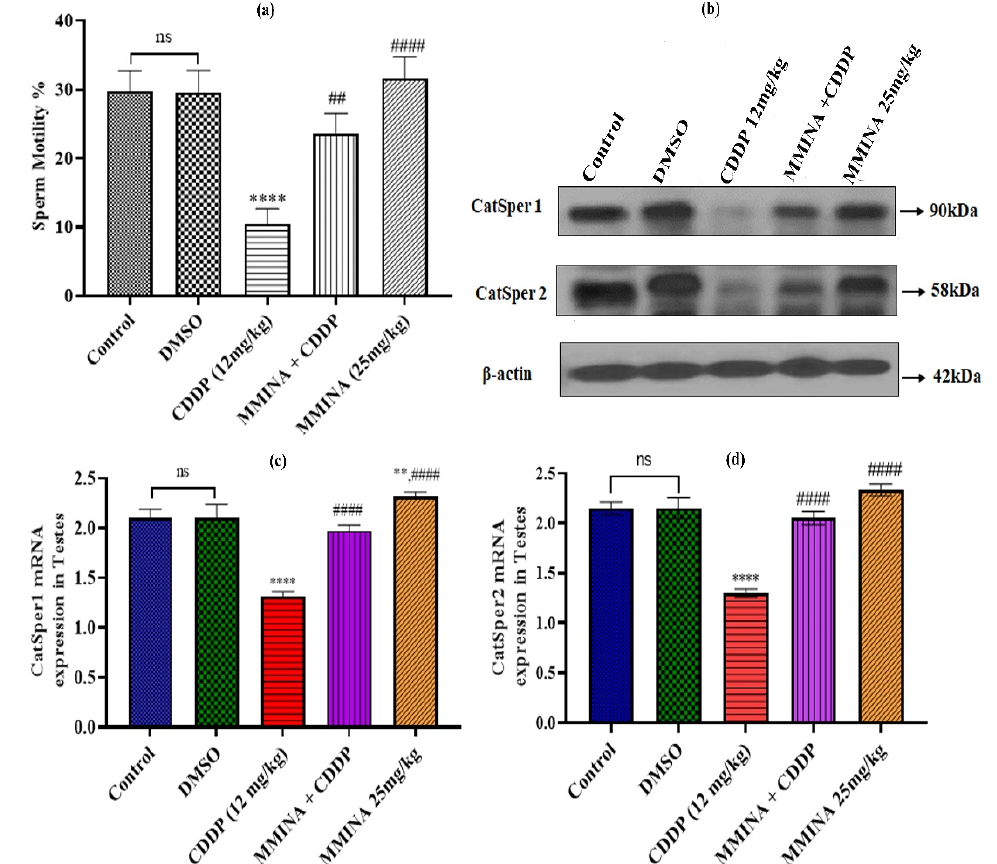
Figure 3. MMINA treatment enhanced sperm motility and activate the CatSper channel. ( a ): The percentage of motile spermatozoa in different treatment groups. ( b ): Western blot analysis indicating the protein expression of CatSper 1 and CatSper 2 channels in various treatment groups. MMINA administration prominently upregulates the expression of both channels in comparison to the CDDP alone exposed group. ( c , d ) Indicated the mRNA expression of CatSper 1 and 2 genes. Data are mean ± SEM, ( n = 7). **, **** indicated significant variation at p < 0.01 and p < 0.0001, respec- tively, versus Control group and ## , #### indicated significant variation at p < 0.05 and p < 0.0001, re- spectively, versus CDDP group. ns= non-significant. Uncropped blots are presented in Supplemen- tary File S3. 3.6. MMINA Attenuated CDDP-Induced Oxidative Stress by Triggering Antioxidant Production A total antioxidant capacity assay (TAC) was performed to measure the cellular an- tioxidant levels of the tissues. CDDP inoculation significantly weakens the total antioxi- dant capacity of the testis ( p < 0.0001, Table 2). Furthermore, antioxidation enzymes com- prising glutathione peroxidase (Gpx) and superoxide dismutase (SOD) activities were sig- nificantly lowered after CDDP treatment ( p < 0.0001). Besides compromised antioxidant defense, the level of oxidative stress parameters, i.e., TBARs and NO, were also signifi- cantly elevated ( p < 0.0001, Table 2). MMINA + CDDP treatment improved the total anti- oxidant capacity of testicular tissue relative to CDDP alone ( p < 0.001). MMINA + CDDP treatment also significantly rescued depletion of Gpx and SOD concentration in compari- son to CDDP alone ( p < 0.0001), and partially restored TBARS and NO levels to near Con- trol levels.